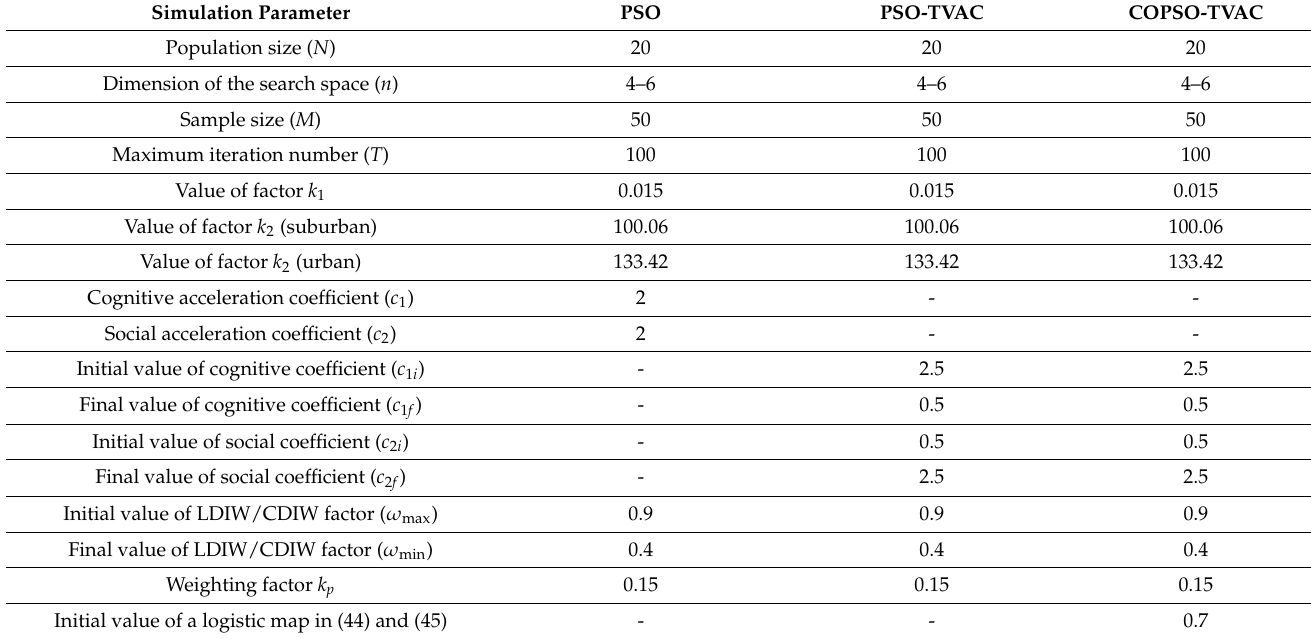
Table 1. The simulation parameters of the PSO, PSO-TVAC, and COPSO-TVAC